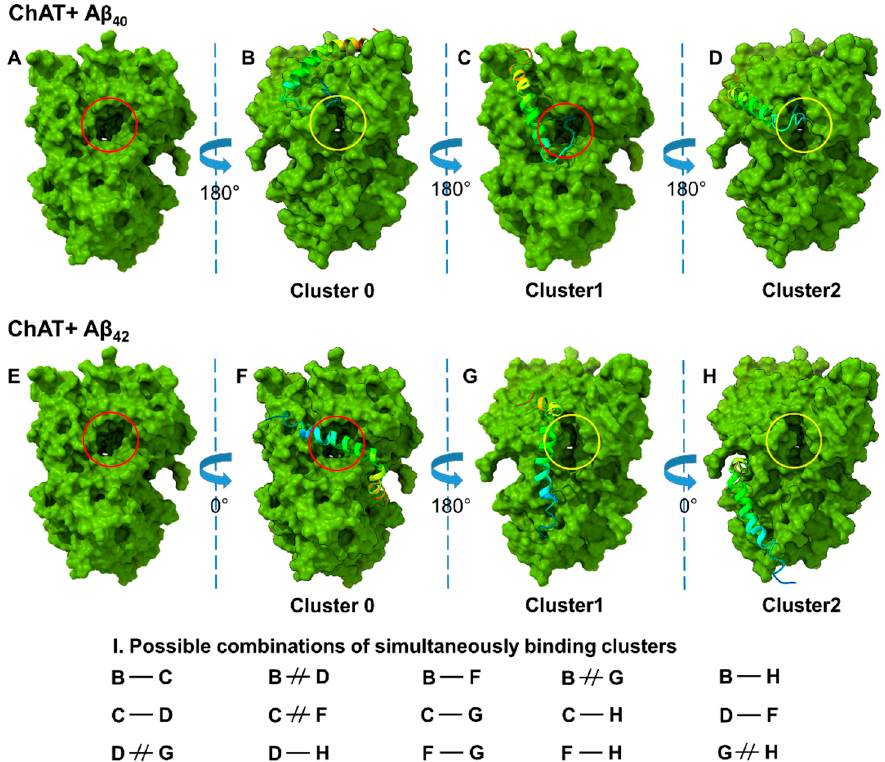
Figure 2. In silico molecular docking analyses reveal the potential binding sites for A β peptides on ChAT. Molecular docking for ChAT and A β peptides was performed using Cluspro web server as described in the method section. ( A ) and ( E ) show the 3D representation of ChAT protein, where the choline-entrance of the catalytic tunnel is indicated by red circle . ( B – D ) show the most probable binding-sites for clusters-0, -1 and -2 of A β 40 peptides, respectively. The yellow circle highlights the Acetyl-CoA-entrance of the catalytic tunnel. A comparison of ( B ), ( C ) and ( D ) indicates that the binding of A β 40 at cluster-1, but not cluster-0 or -2, will most likely block the entrance of choline into the catalytic tunnel of ChAT, whereas A β 40 binding in cluster-2 will interfere with the Acetyl-CoA-entrance site. ( F )–( H ) illustrate the most probable binding-site clusters -0, -1, and -2 for A β 42 peptide, respectively. Similar to A β 40 , one out of the top three clusters of A β 42 (cluster-0) also overlaps the choline-entrance site of the catalytic tunnel ( F ). Theoretically, it is possible that two A β peptides can simultaneously bind to one ChAT molecule. The table ( I ) shows all such possible/excluding combinations. For example, the cluster-0 ( B ) will most likely exclude simultaneous binding of another peptide at cluster-2 ( D ) or vice versa. This is denoted as B ≠ D. In contrast, it is possible for two A β 42 peptides to bind simultaneously to ChAT, namely at cluster -0 and -1 ( F – G ), or at cluster-0 and -2 ( F – H ).